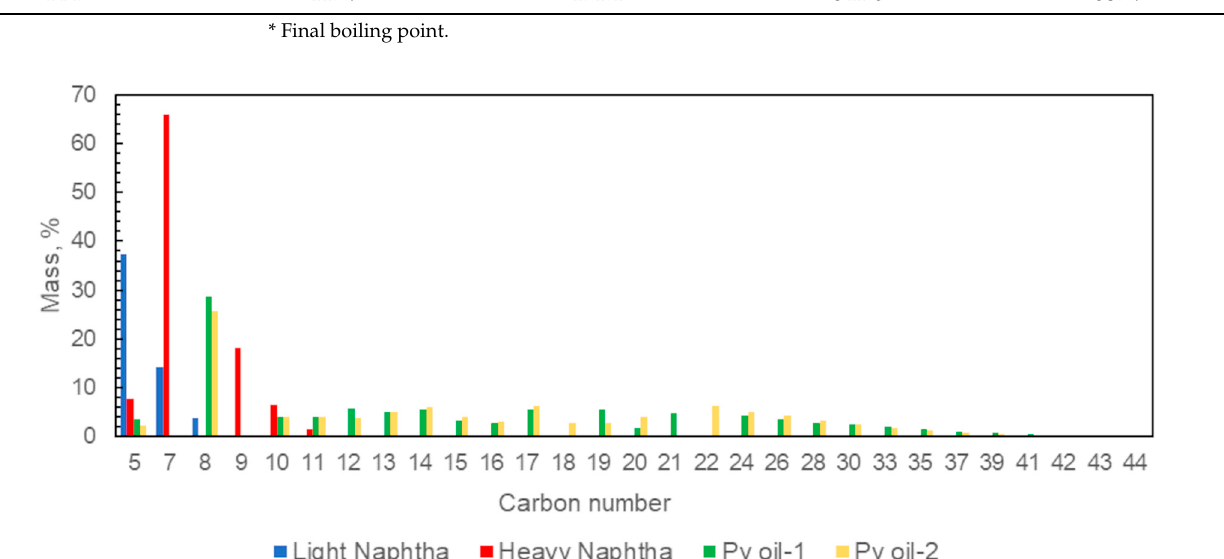
Figure 2. Alkane profile of the